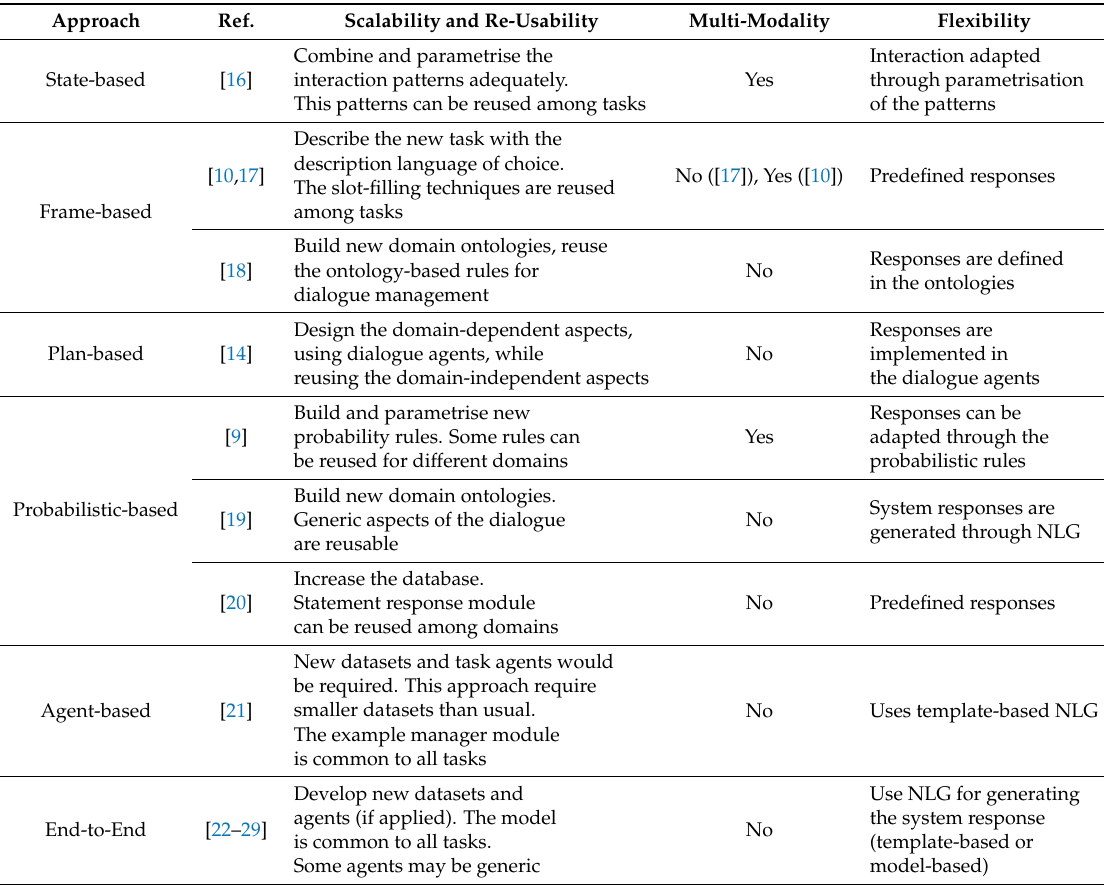
Table 1. Comparison among the works presented in Section 2. Each approach has been evaluated according to scalability, multi-modality and